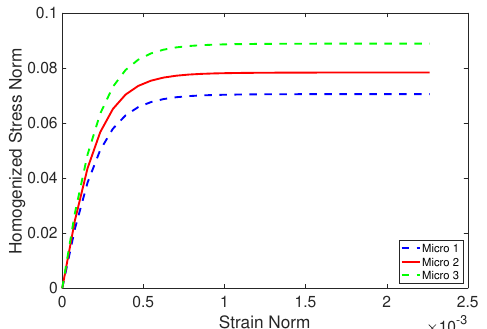
Figure 10. Comparison of homogenized behavior of of 3 microstructures under monotonic loading, the geometrical features for these 3 microstructures are [0.358, 0.455, 0.278, 0.178], [0.313, 0.465, 0.36, 0.226], [0.478, 0.28, 0.143, 0.064] (respectively, first, second, third and linear path probabilistic functions). By changing the microstructure, there are different behaviors (Stress (GPa) vs.